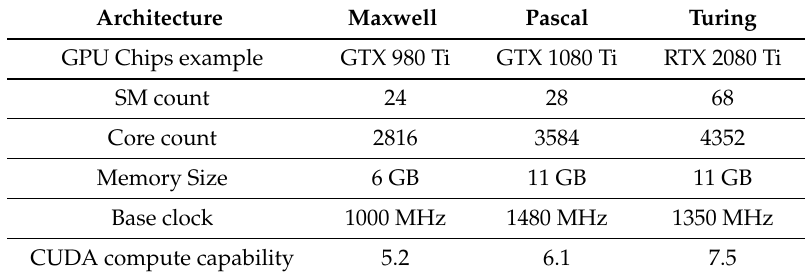
Table 2. Specifications of Compute Unified Device Architecture (CUDA)-enabled NVIDIA GPU